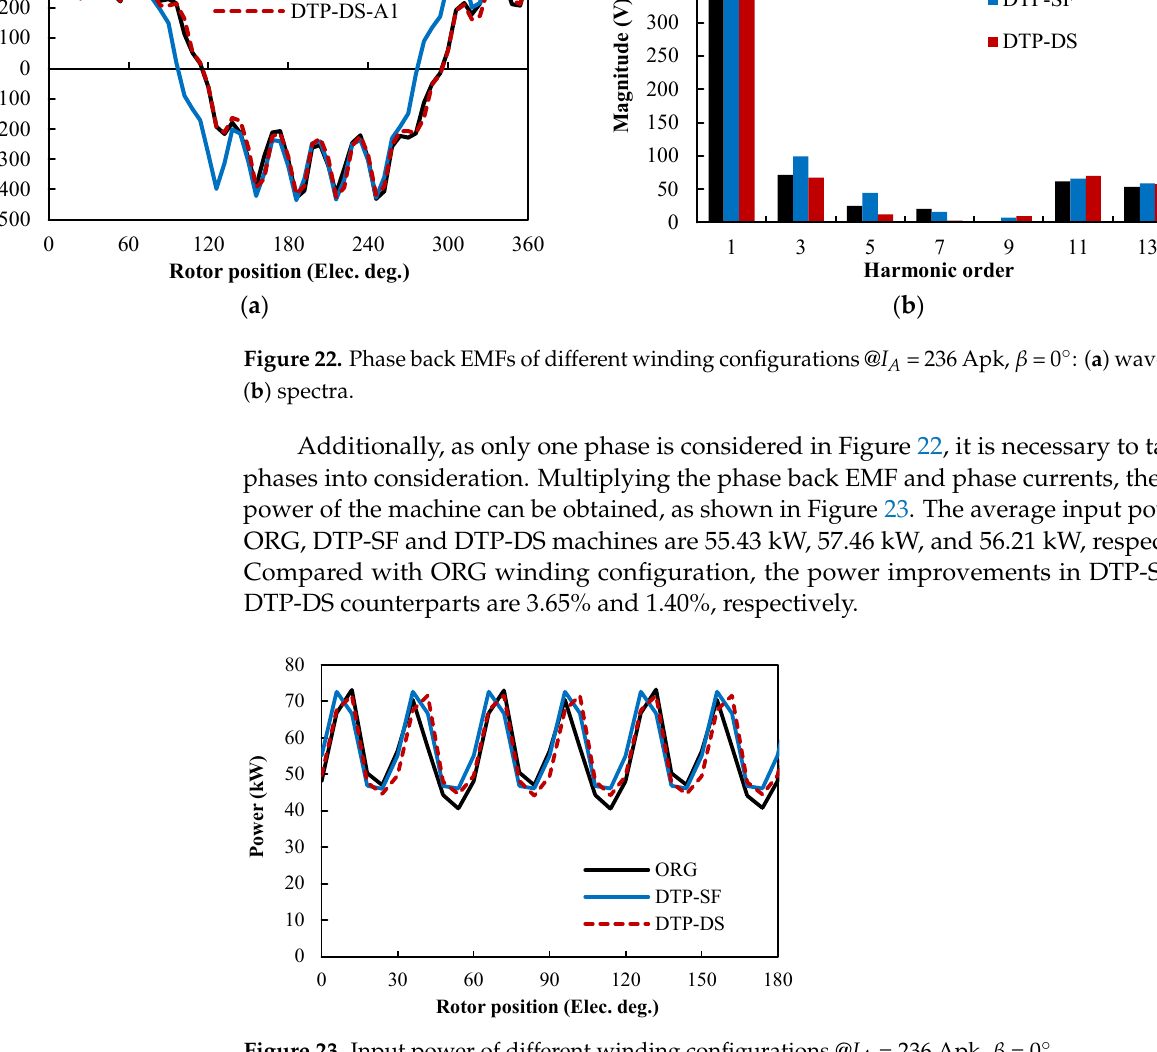
Figure 23. Input power of different winding configurations @ I A = 236 Apk, β = 0°.